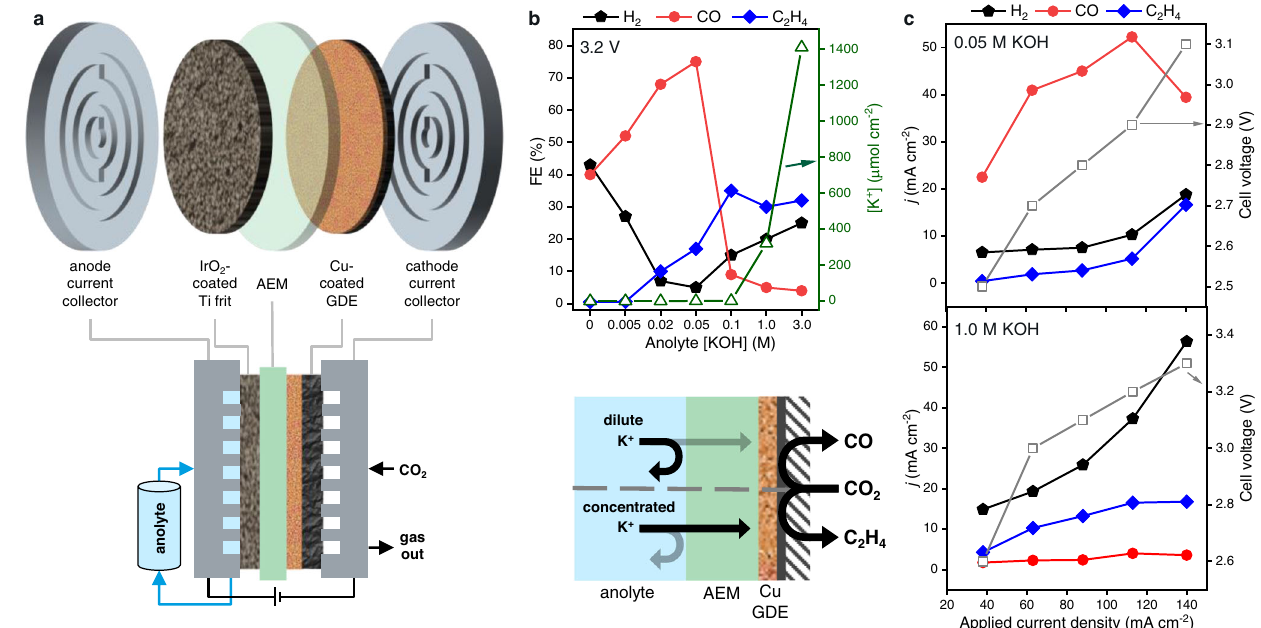
Fig. 1 | In fl uenceofanolyteconcentrationonCO 2 electrolysis selectivity. a Cell schematic showing the assembly of electrodes, anion-exchange membrane (AEM), andliquidanolyte. b Faradaicef fi ciency(FE)distributionofthemajorproductsH2, C 2 H 4 and CO (complete dataset including minor products available in Supple- mentaryFig.2)duringoperationatconstantvoltage(3.2V)asafunctionofanolyte concentration(x-axisnottoscale).Hollowtrianglesymbols(righty-axis)depictthe amountofK + extractedfromthecathode fl owchannel,collectedbyinjectionofan